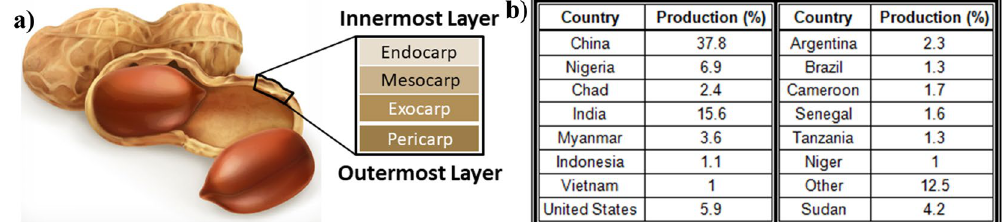
Figure 1. ( a ) schematic representation of peanut structure purchased from iStockphoto.com, ( b ) annual global peanut production 67